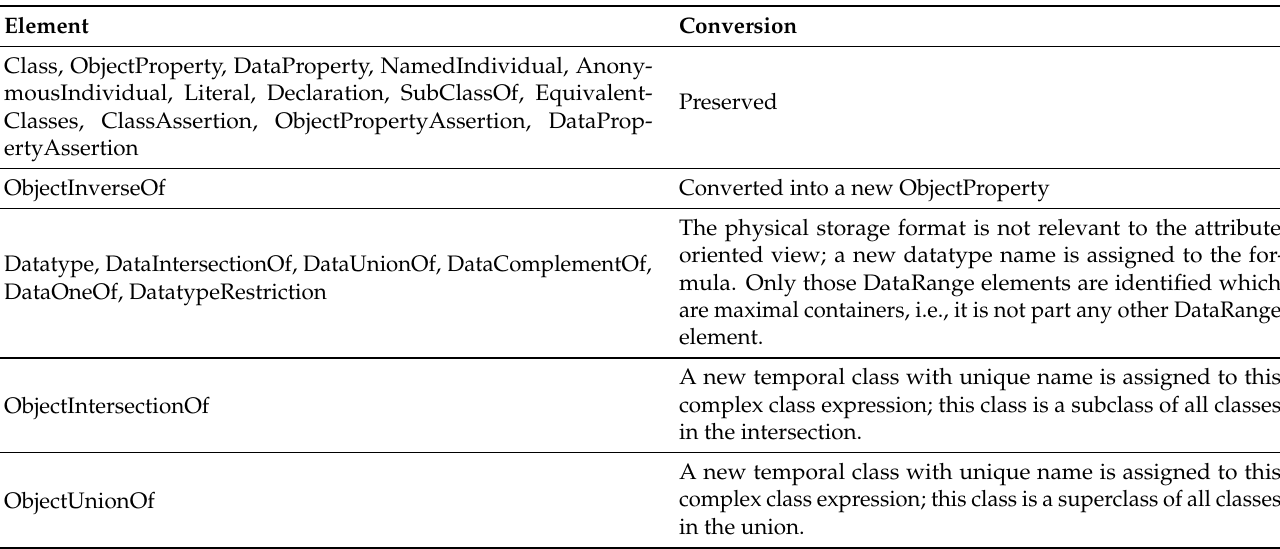
Table 3. Transformation rules used in